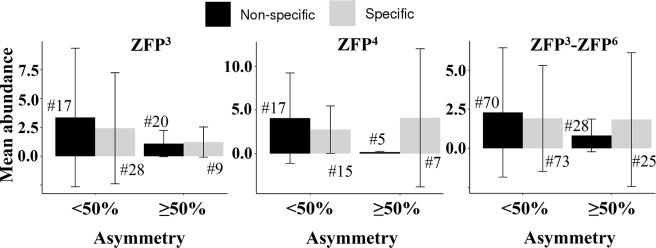
Relationship between protein abundance and asymmetry.The zinc-finger proteins (ZFPs) are divided into two groups depending on the percentage of asymmetric zinc finger pairs in each protein: symmetric zinc-finger proteins (containing <50% asymmetric pairs) and asymmetric zinc-finger proteins (containing ≥50% asymmetric pairs). This classification was performed separately for non-specific binding (on the basis of electrostatic net charge) and specific binding (on the basis of the specificity score). The mean abundance of each group is shown by the bar plot. The analysis was performed separately for zinc-finger proteins with 3 (left), 4 (middle), and 3–6 (right) zinc-finger domains.